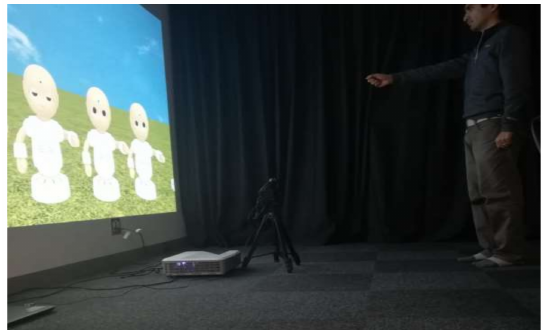
Figure 3. A person standing in front of the projection.